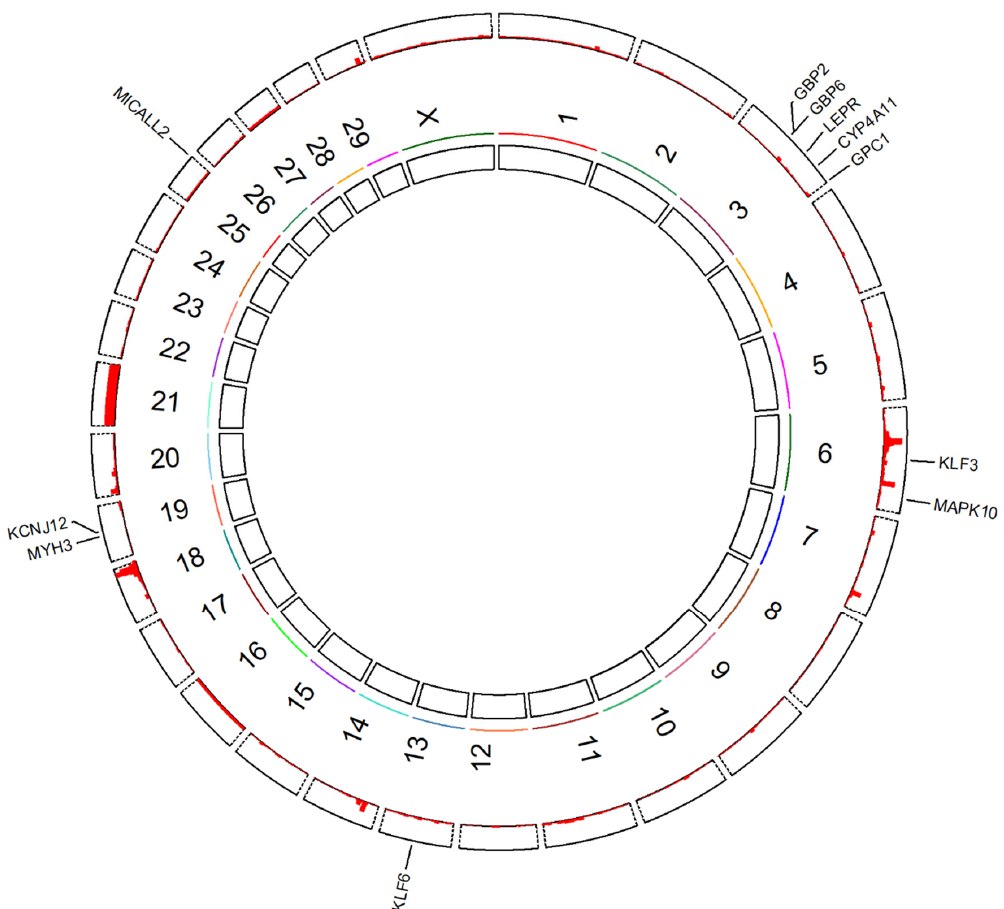
Figure 5. Circular graph of the densities of quantitative trait locis (QTLs) and identified candidate genes from other similar studies [23–32]. Note: the QTL densities in the red histogram were counted by 1 mega base pairs (Mb) windows.